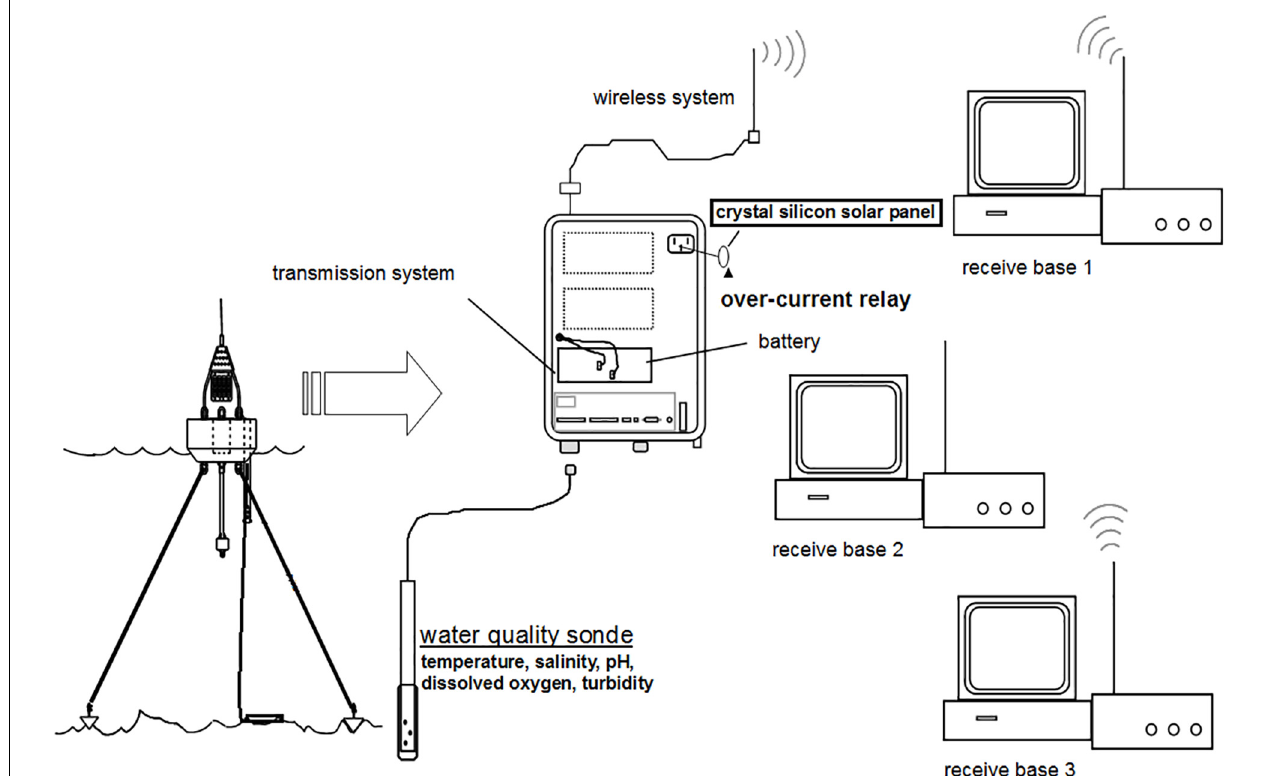
FIGURE 2 | Schematic diagram of the novel real-time water quality monitoring system.